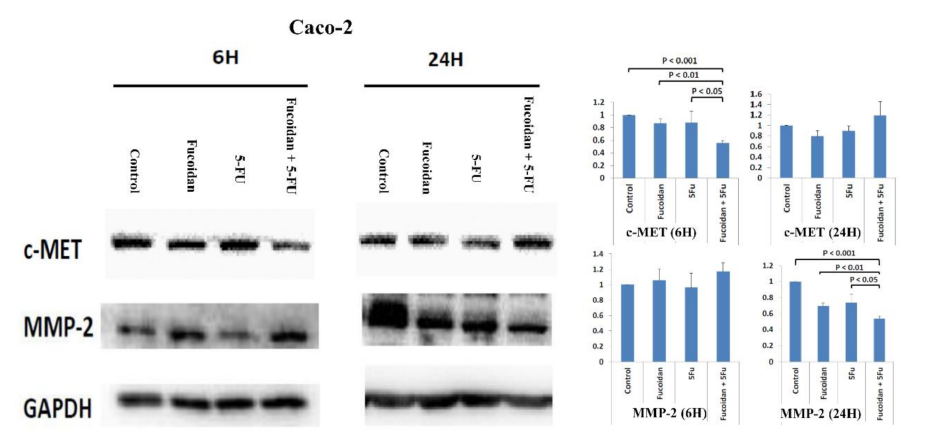
Figure 8. Protein expressions of c-MET and MMP-2 in Caco-2 cells after treatment with LMWF, 5-FU, and combination of LMEF and